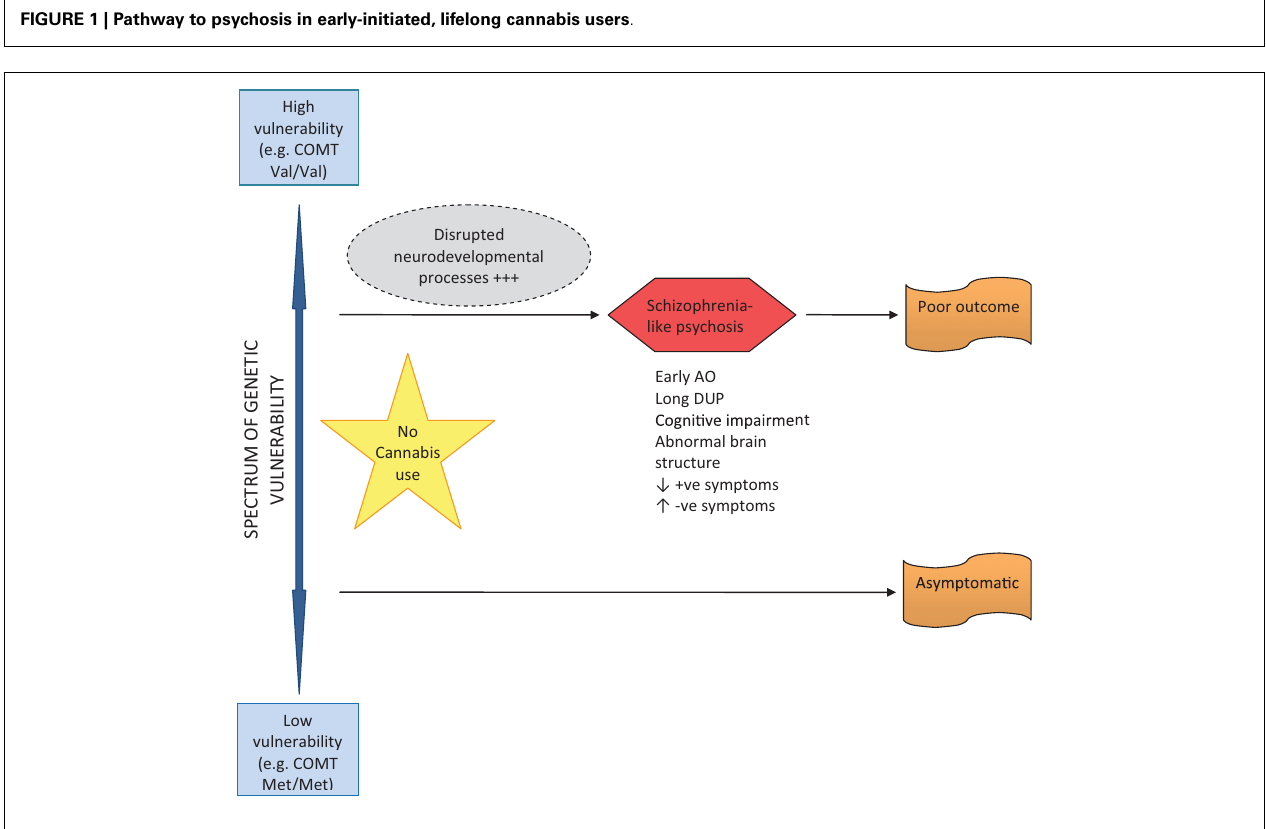
FIGURE 2 | Pathway to psychosis in non-cannabis users